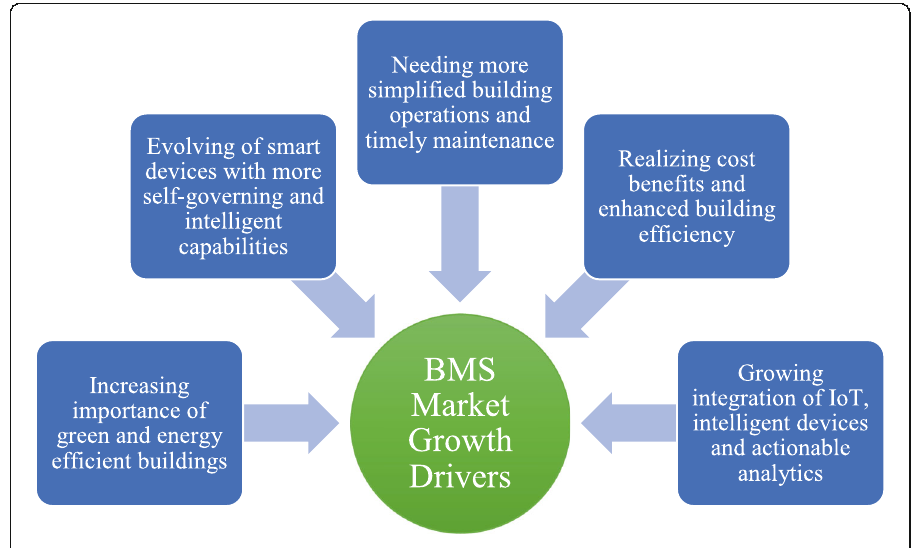
Fig. 2 Main drivers of the building management systems market